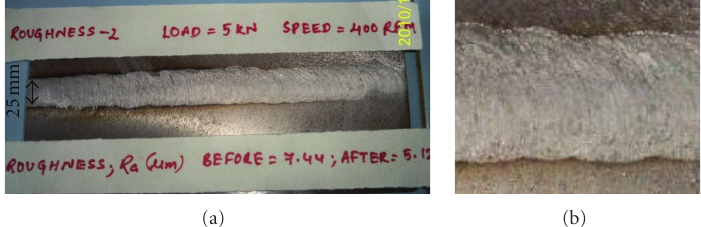
Figure 2: Macroimage of the deposition made using a normal load of 5kN and spindle speed of 400 rpm. On the right side a small region which was magnified from long track is shown.